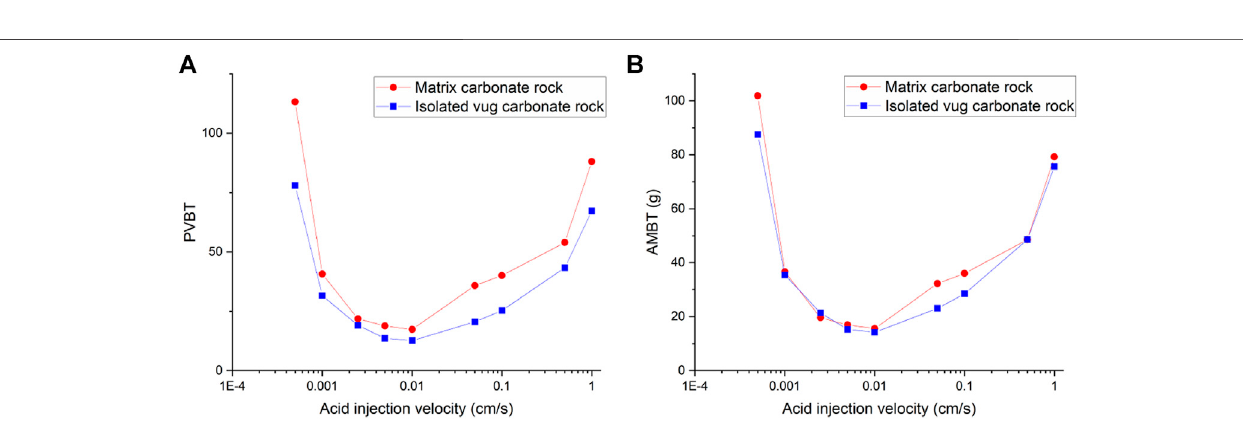
Frontiers in Earth Science |